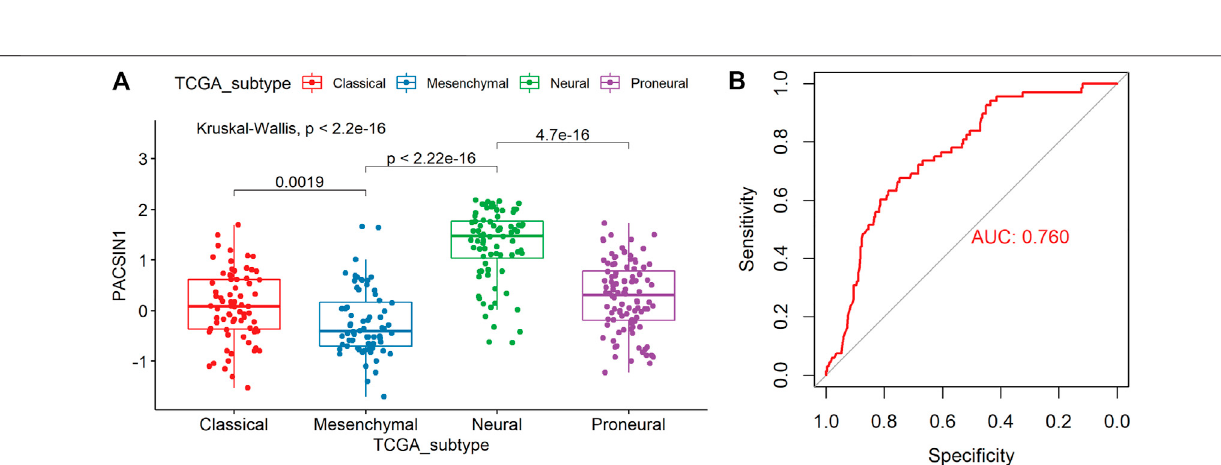
Frontiers in Molecular Biosciences |